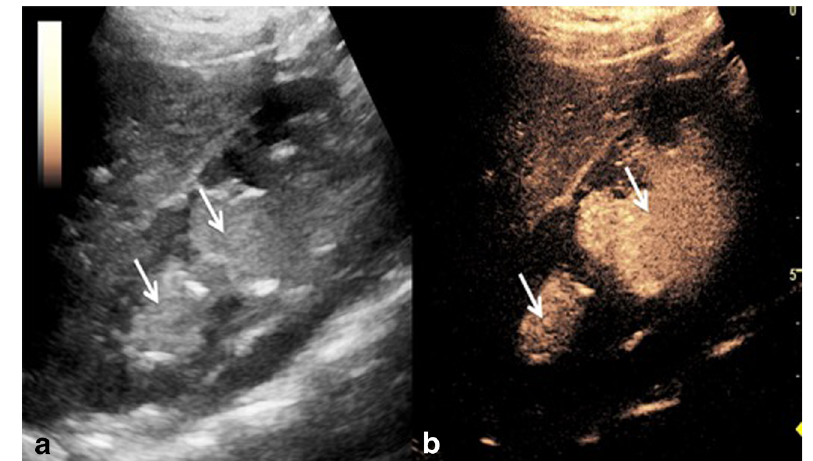
Fig. 5 Contrast-enhanced voiding urosonography (CEVUS) with dual screen mode. The right kidney is duplex and is simultaneously demonstrated in (a) greyscale mode and (b) contrast-only mode during bladder filling. Echogenic contrast is seen filling the upper and lower